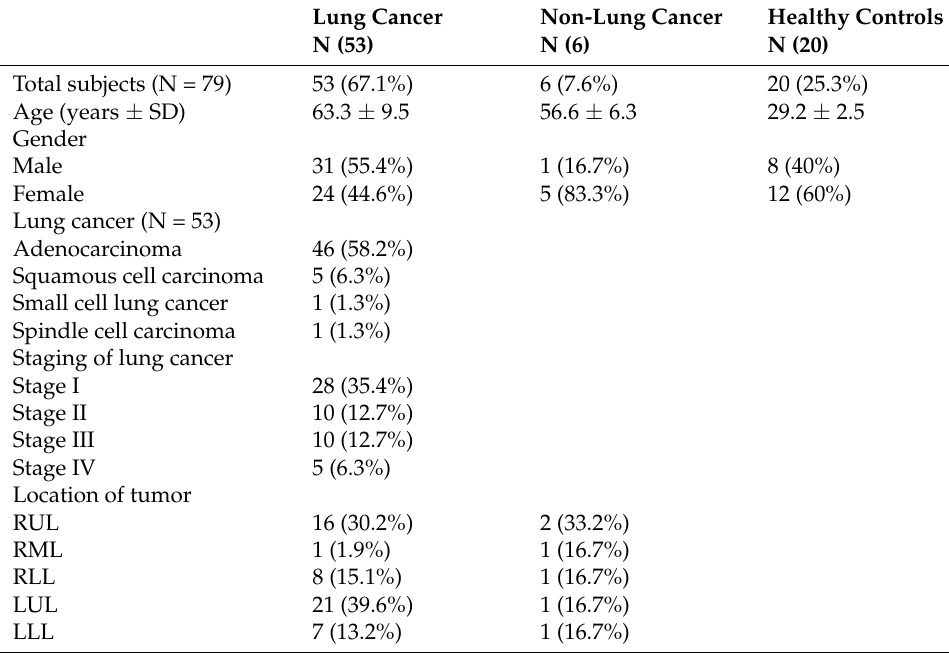
Table 1. Characteristics of enrolled participated subjects in the